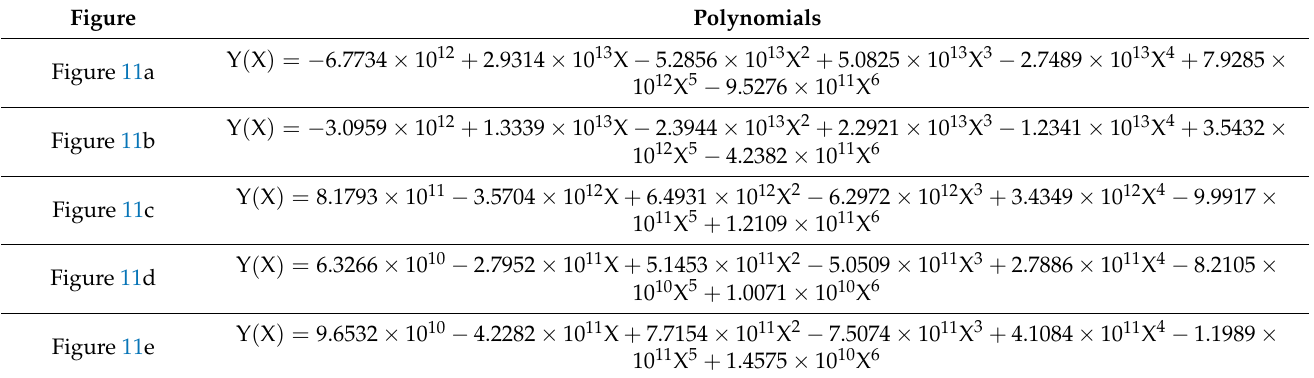
Table 4. Comparison of performance with plasmonic sensors reported in the literature.